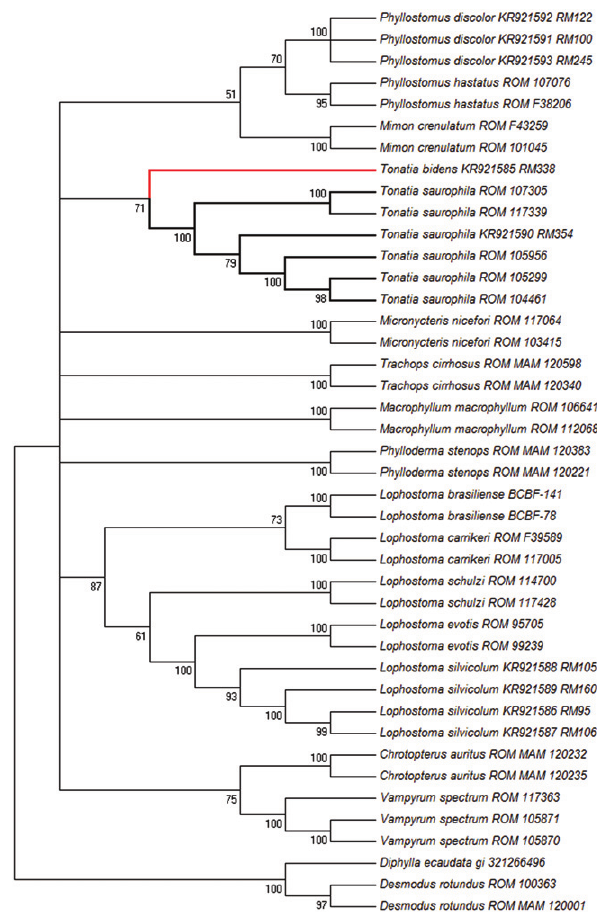
Figure 11. Neighbor-joining (NJ) dendogram describing relation- ships among genera of bats in Phyllostominae and calculated from COI sequence data (the species of Tonatia are highlighted). The best model for the evolutionary distance was computed using Tamura-Nei method. The sequences under the numbers KR921585 to KR921593 belong to specimens collected in the Cerrado of Mato